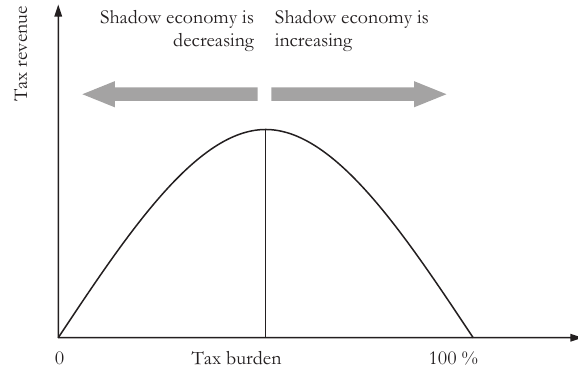
Fig. 2 – The impact of tax burden on the size of the national shadow economy. Source: Williams & Schneider (2013) On the other hand, the opinion on the exceptional impact of tax burden on the size of the shad-